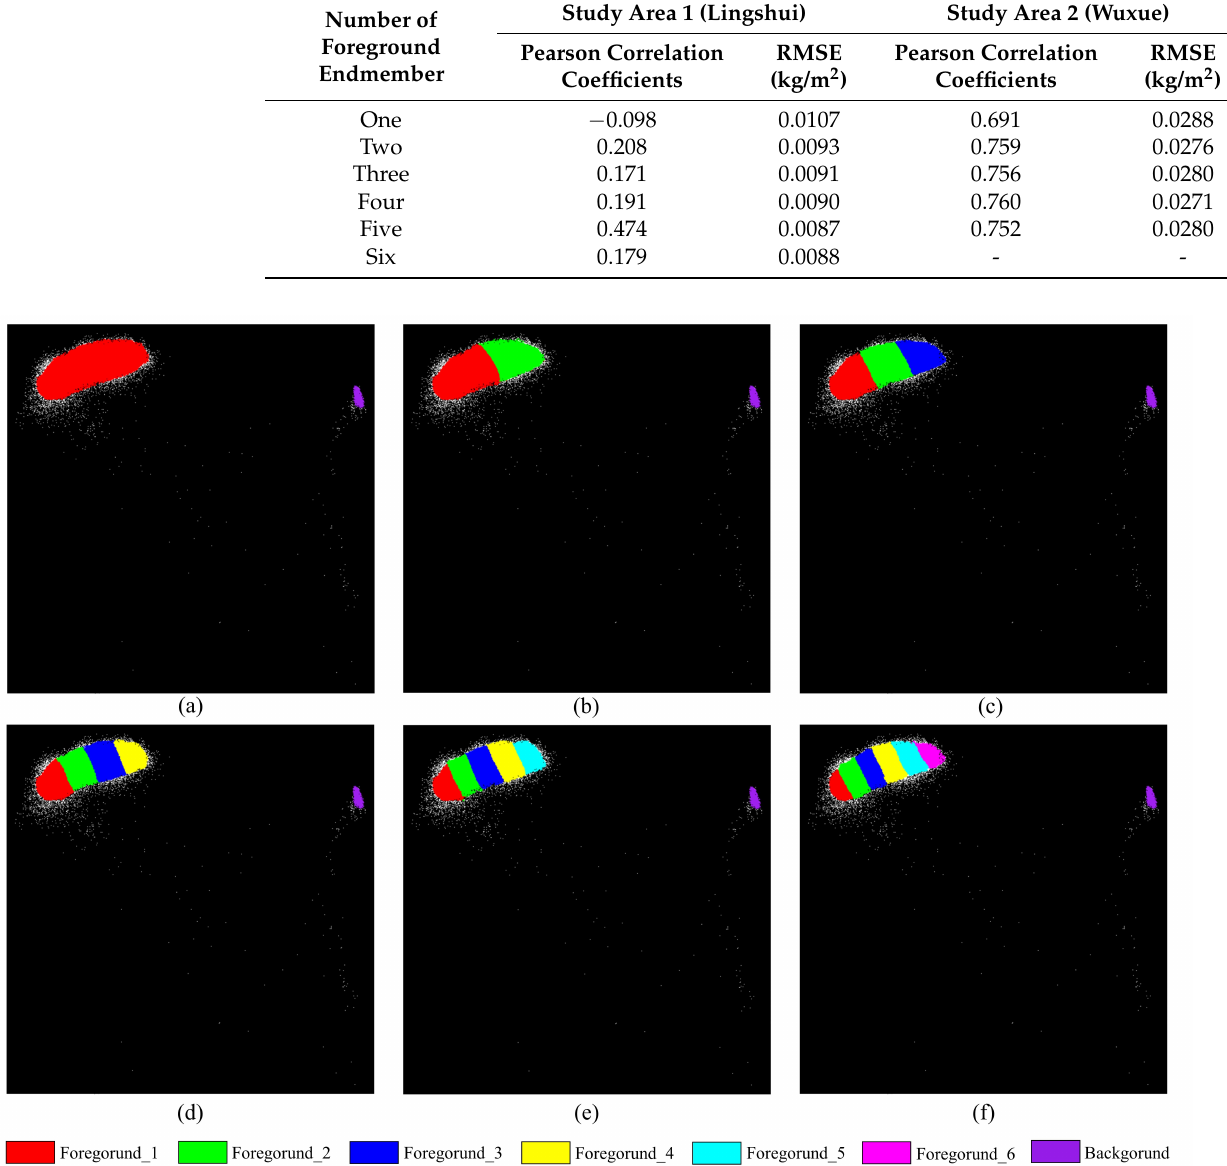
Table 3. The Pearson correlation coefficients of yield and the foreground abundances and the accuracy of NU-BGBM under different inputs.